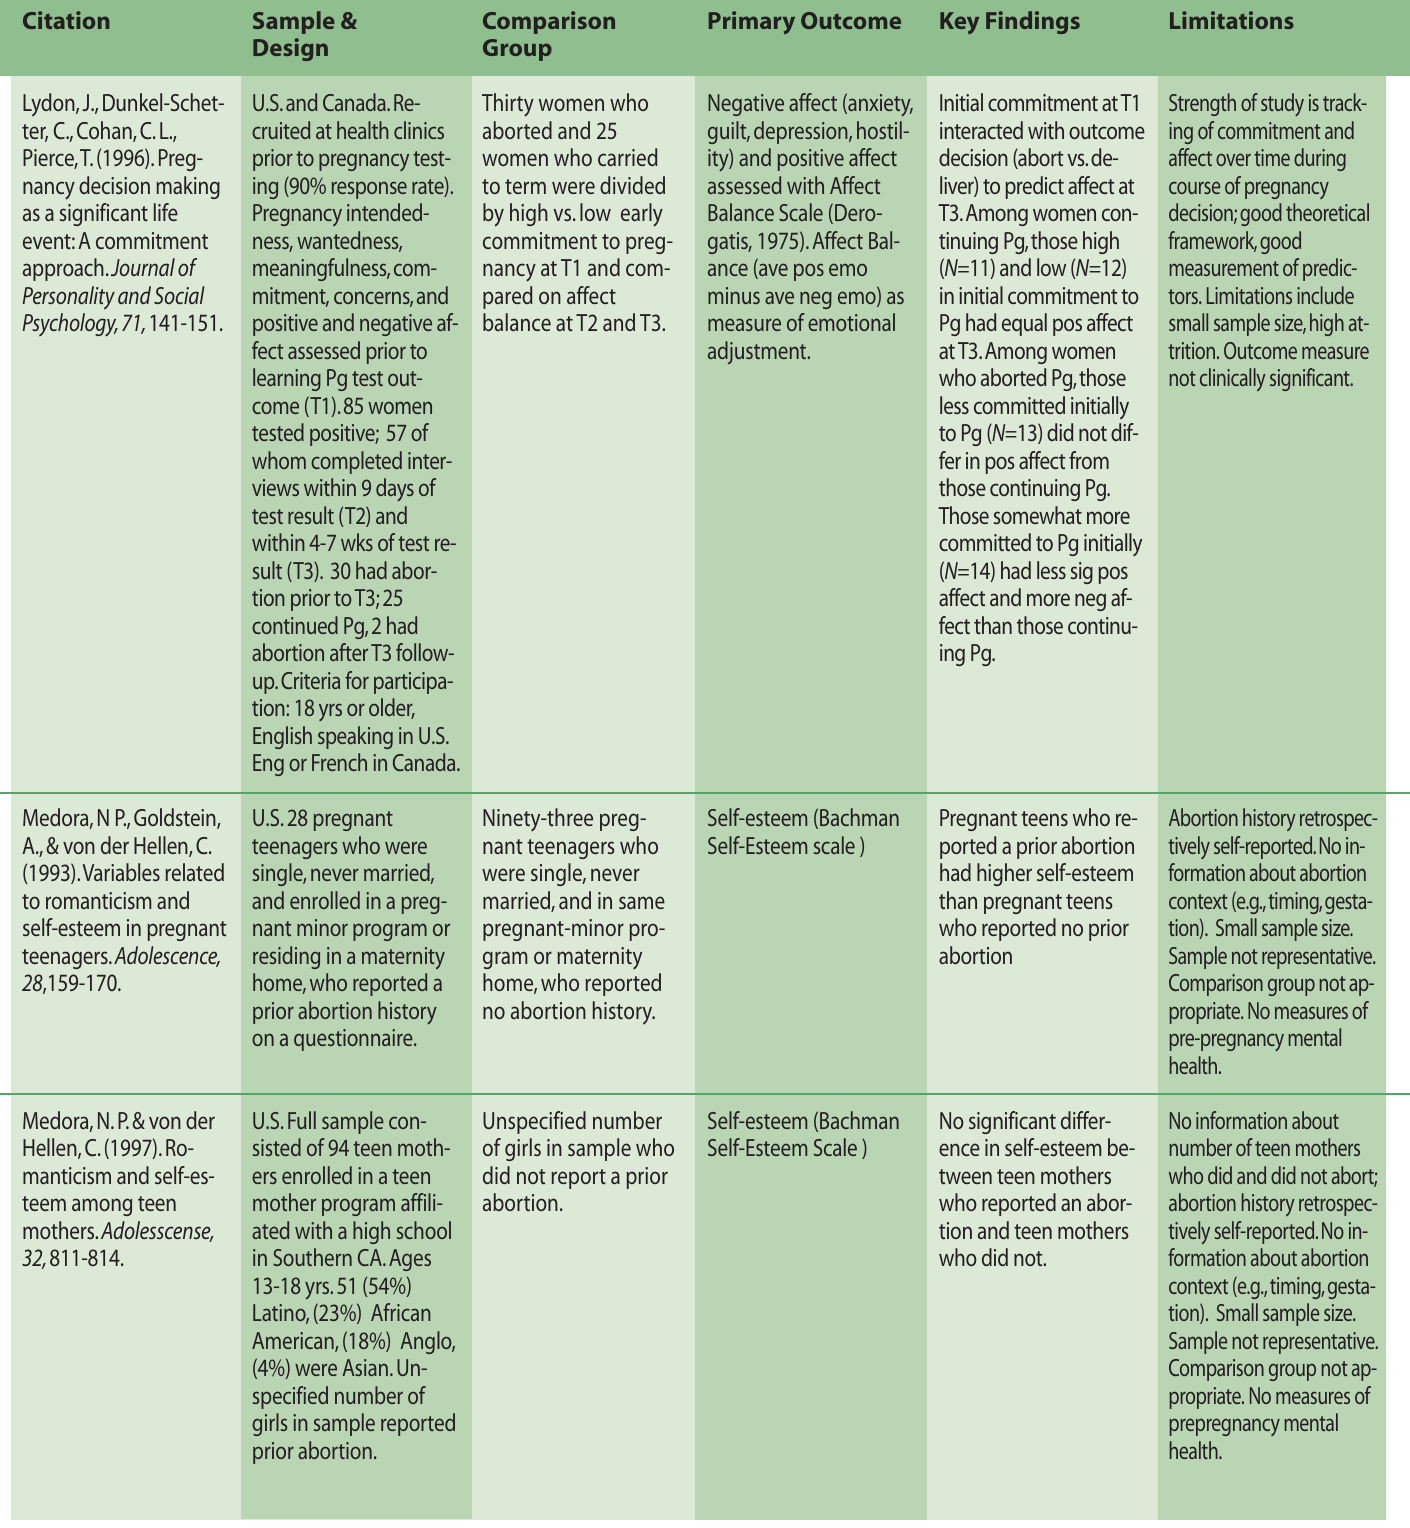
Table 3A: Primary Data Comparison Group Studies UNITES STATES SAMPLES